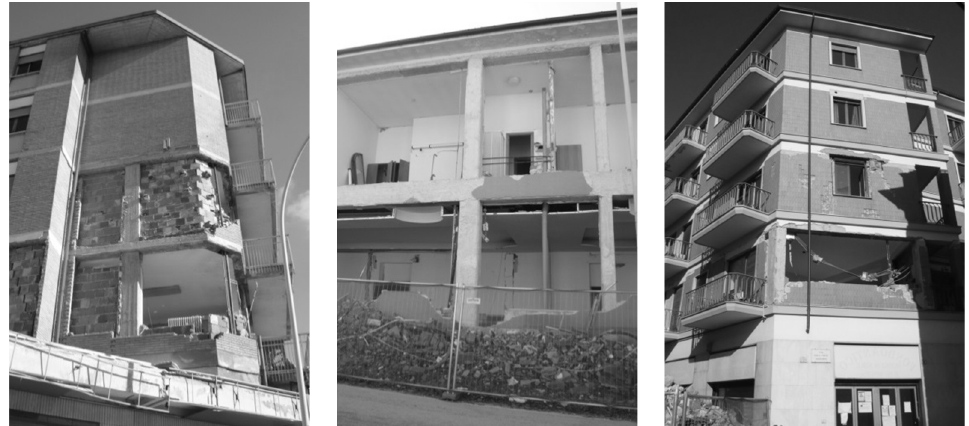
Figure 1. Partial and complete out-of-plane collapses of infilled walls during the L’Aquila earthquake (2009), Italy.